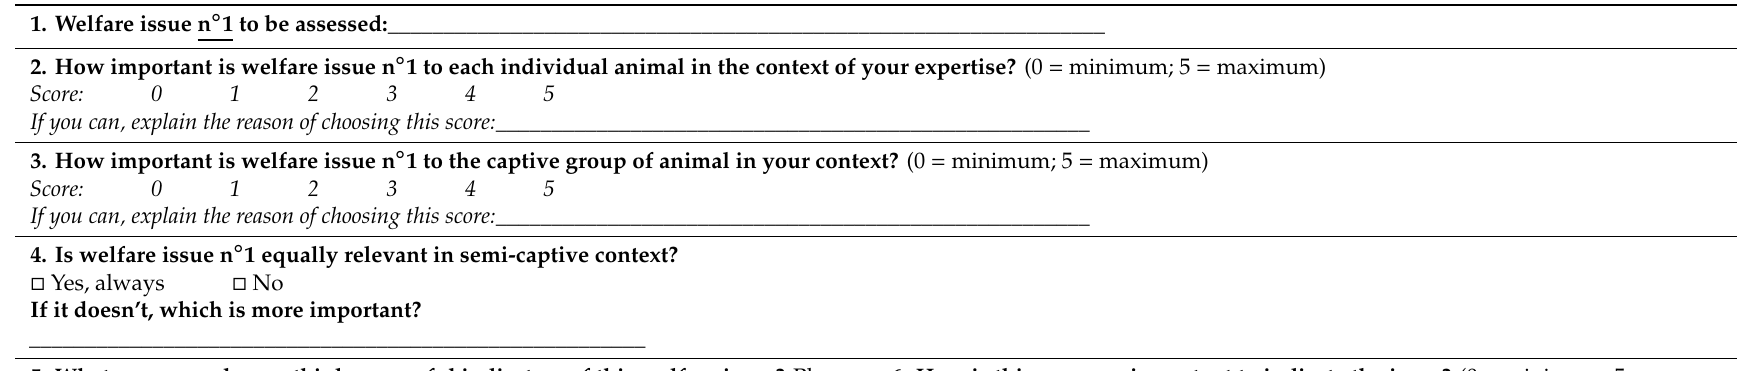
Table A2. Questionnaire. It was designed and used by the University of Padua team for the cited expert opinion survey